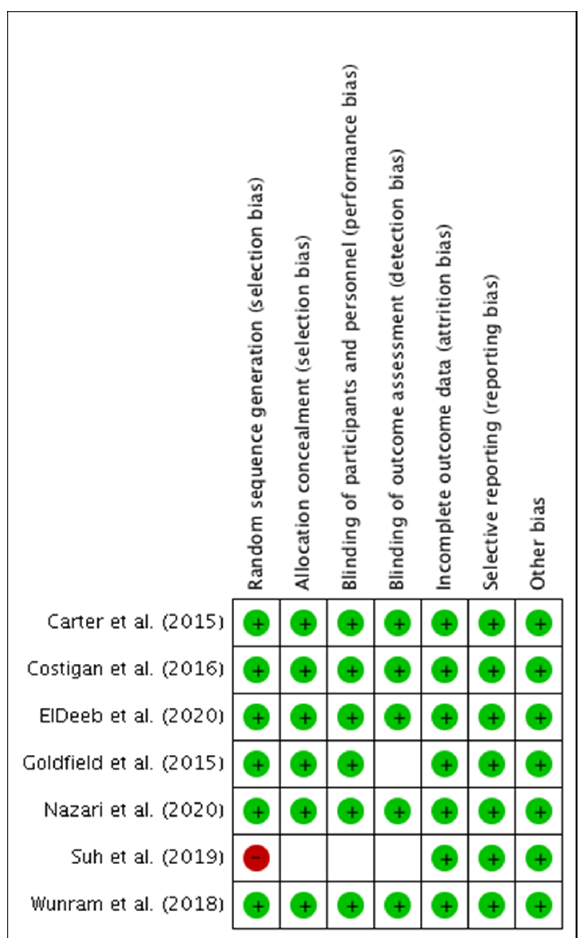
Figure 4. Risk of bias summary: Review authors’ judgements about each risk of bias item for each included study.